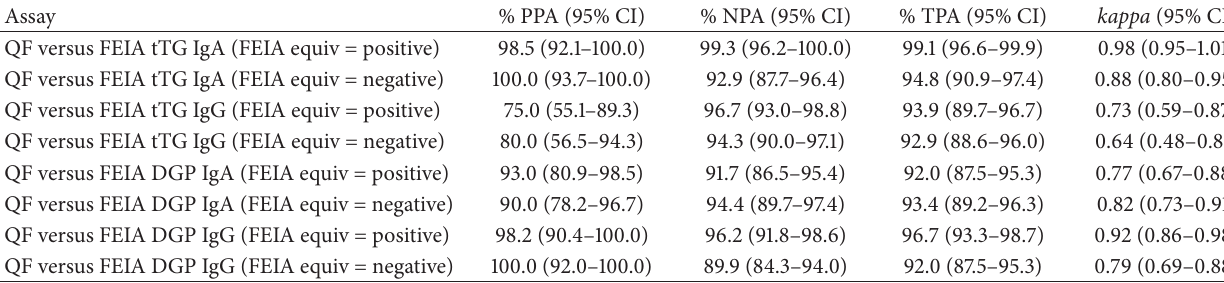
Table 3: Qualitative agreements between all